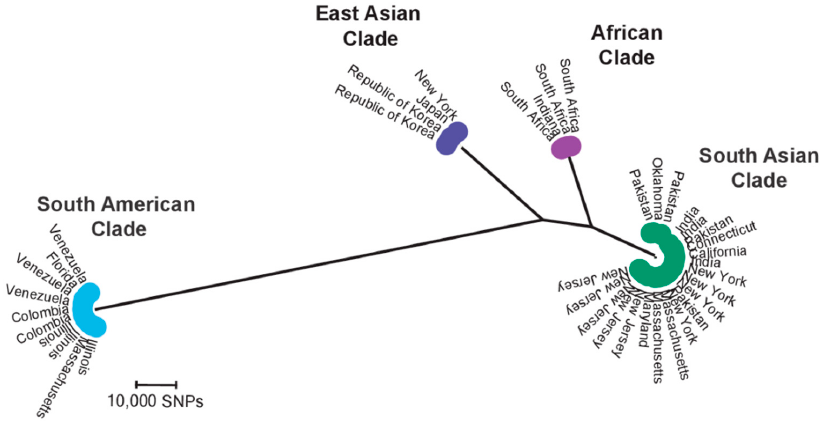
Figure 5. Whole ‐ genome sequence analysis of the US C . auris (up to 2018) isolates reveals the existence of four major clades. Isolates representing all identified clades have been recovered from the U.S. The Iranian clade is not shown in this figure. Adopted the permission from Chow et al., 2018 [201]. Antifungal susceptibility profiles vary depending on the clade [131,172,173,195], with the drug resistance reaching up to 7%, 35%, and >90% against echinocandins [172], AMB [172], and fluconazole [131], respectively. Similar to C . glabrata , resistance against two or three major classes of antifungals is frequently observed [131,172]. Amino acid changes in Erg11p are closely associated with resistance